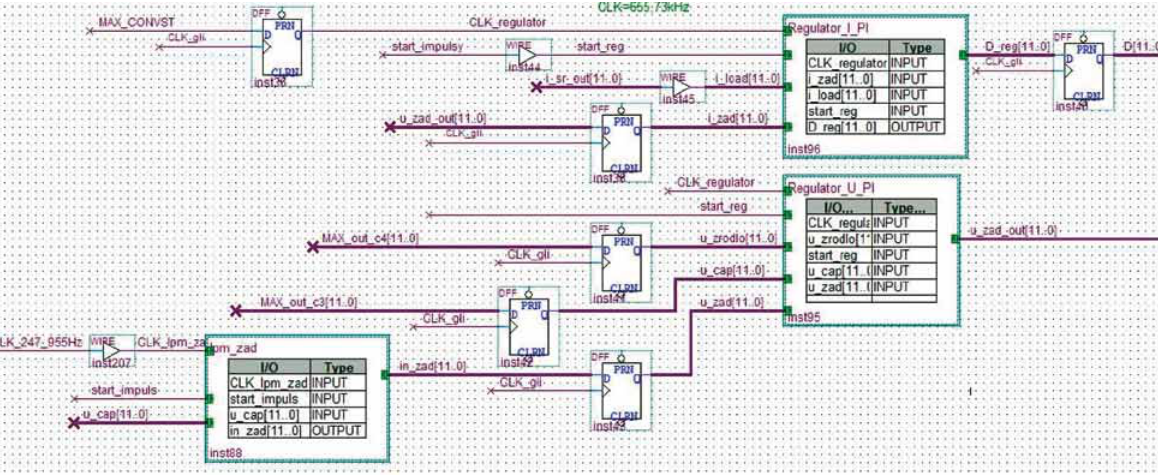
Fig. 2. Diagram of the implemented control